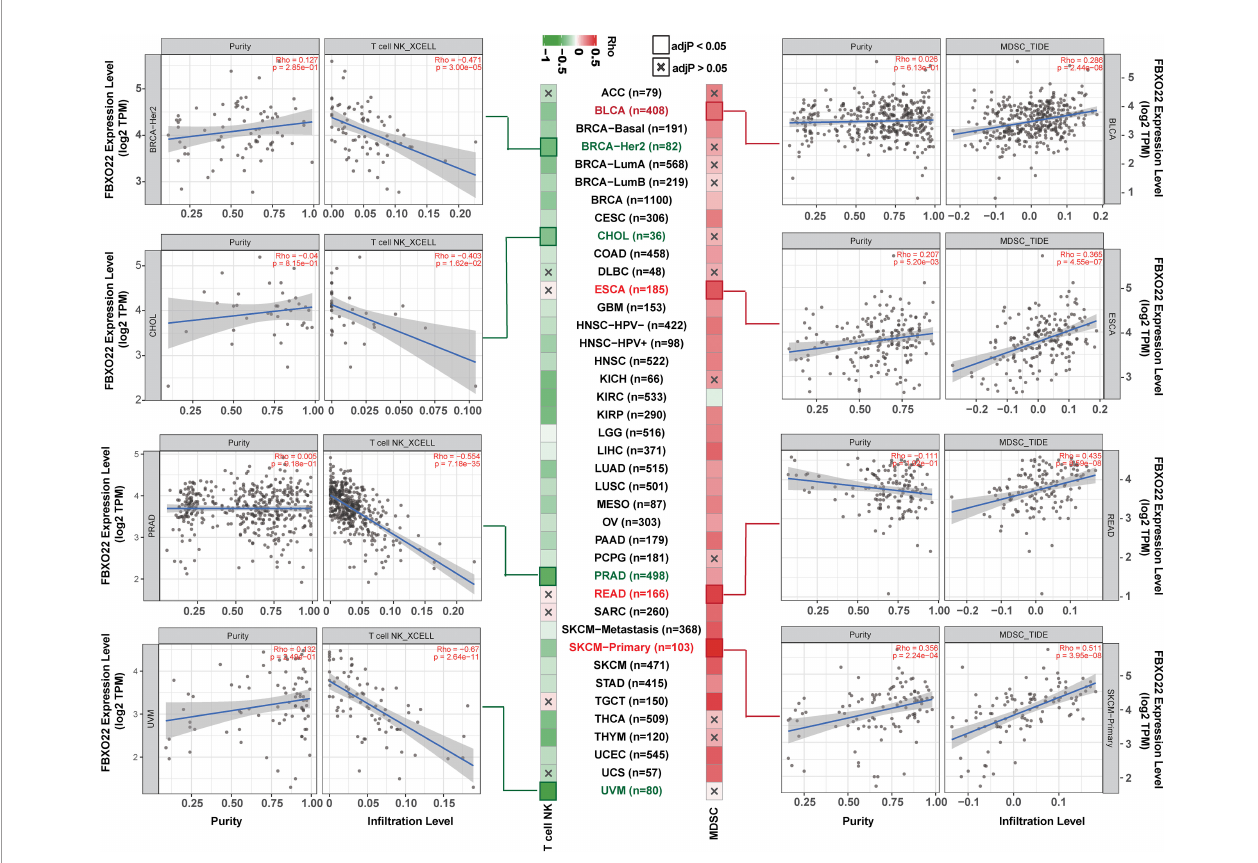
FIGURE 6 | Natural killer (NK) T-cell and myeloid-derived suppressor cells (MDSCs) in different tumor tissues from TCGA. The correlation between FBXO22 expression and NK T-cell in fi ltration levels was estimated using XCELL algorithms, and the MDSC in fi ltration levels were estimated using TIDE